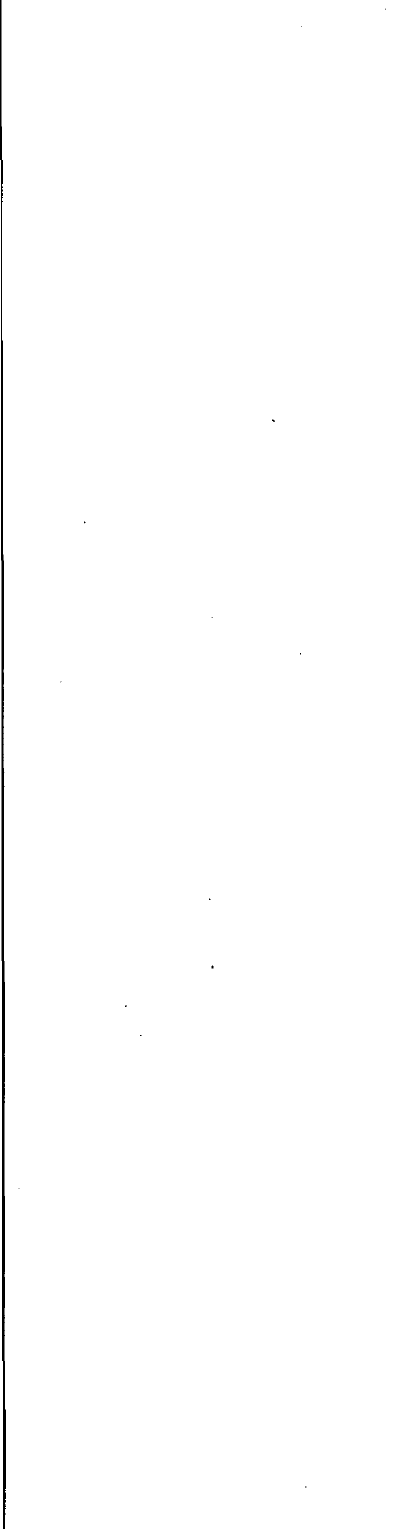
' Figure 1: The student > logging protocol used for interaction